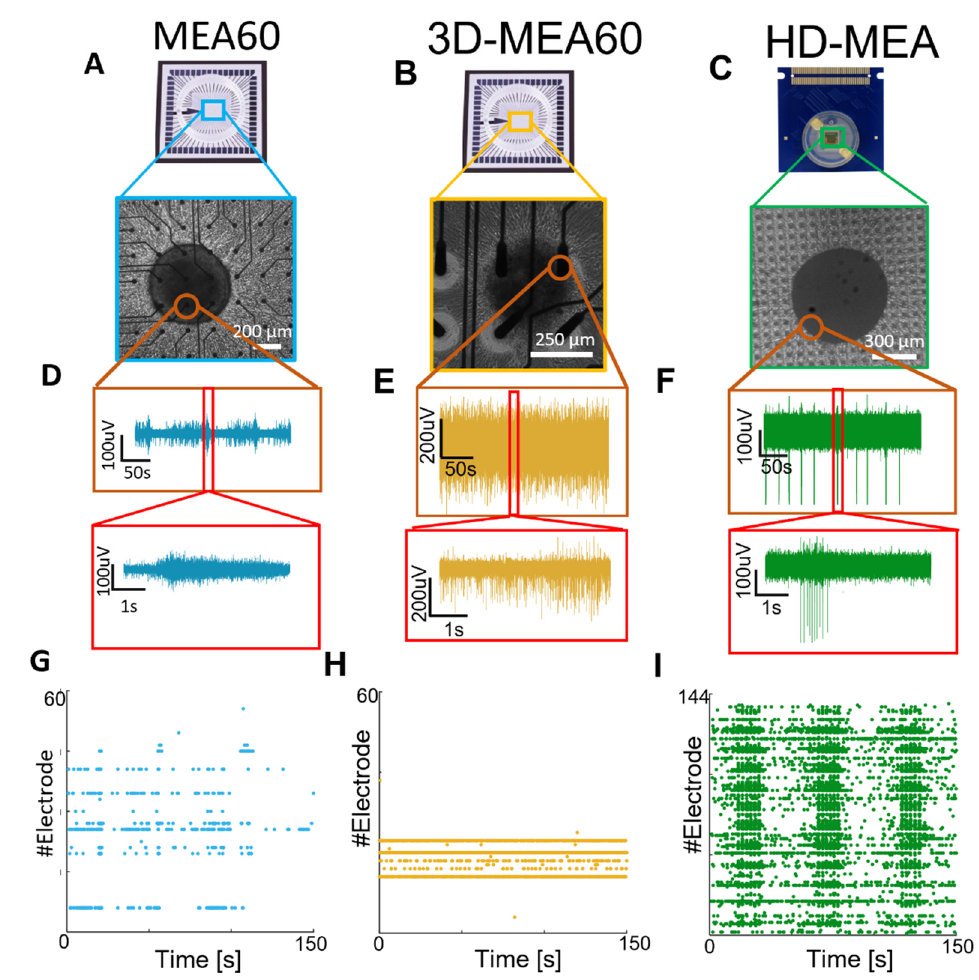
Figure 3. Qualitative comparison between the activity recorded by the MEA60, the 3D-MEA60, and HD-MEAs. ( A – C ) Picture showing a neurospheroid at DIV 49 on ( A ) the MEA60 (scale bar 200 µ m), ( B ) the 3D-MEA60 (scale bar 200 µ m), and ( C ) HD-MEAs (scale bar 300 µ m). ( D – F ) Exemplificative raw data traces recorded by one electrode placed below the neurospheroid growing on ( D ) the MEA60, ( E ) the 3D-MEA60, and ( F ) HD-MEAs. A 5 min and 5 s close-up of activity are shown in the orange and red boxes, respectively. ( G – I ) Raster plot showing 150 s of activity exhibited by a neurospheroid recorded by ( G ) the MEA60, ( H ) the 3D-MEA60, and ( I ) HD-MEAs. Each dot represents a detected spike at the given electrode index (y axis).